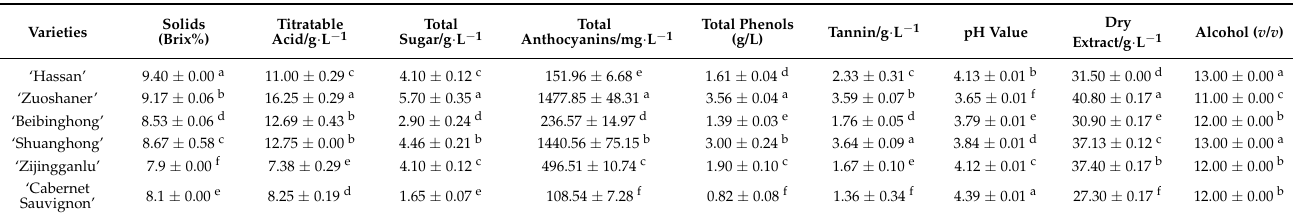
Table 2. The basic physical and chemical indicators of the original